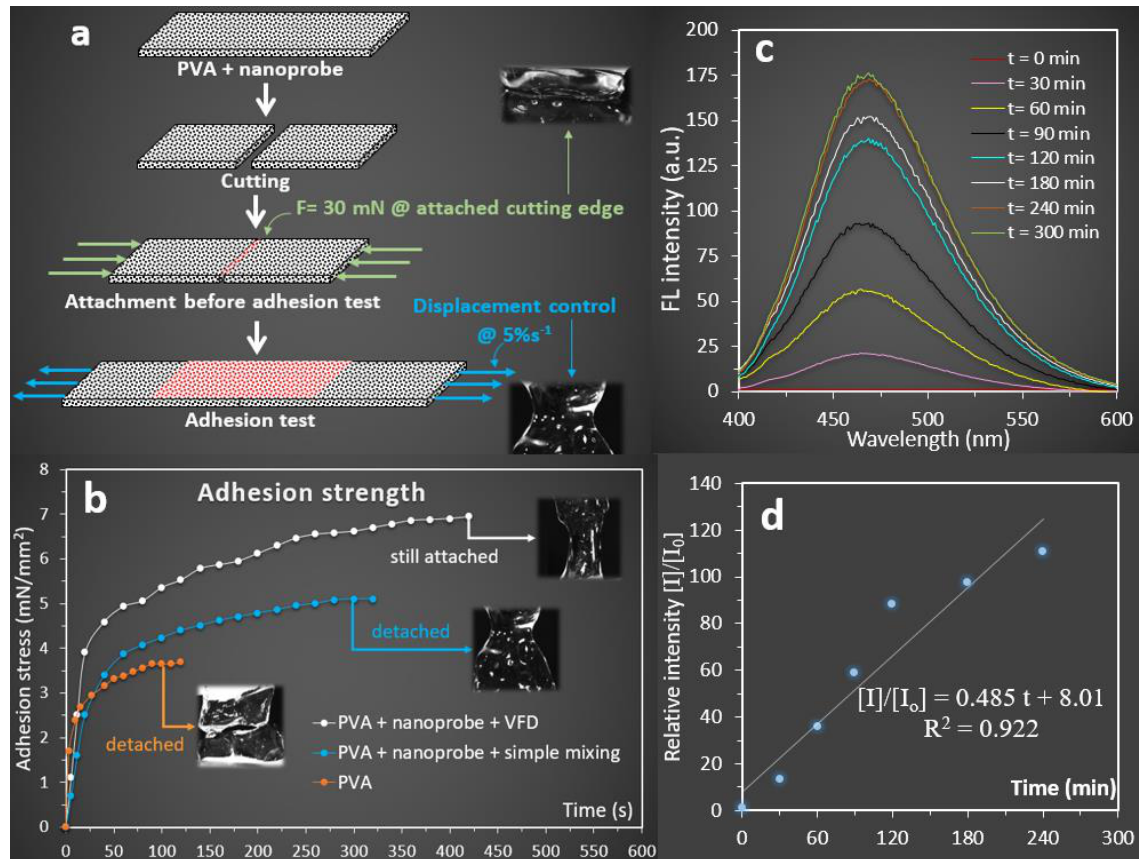
Figure 6. ( a ) Schematic drawings including camera images to describe the adhesion test procedure. ( b ) Comparison of the adhesion strength of PVA-based gels including PVA (blue line), traditionally prepared PVA + nanoprobe (blue line), and VFD-driven PVA + nanoprobe prepared at 4000 RPM (red line). Inset: camera images (×4) were captured during the measurement of the self-adhesion property. ( c ) Change in the fluorescent intensity of the release media showing the release of nanoprobe from the injectable bioadhesive PVA gel over time, and ( d ) change in relative fluorescent intensities of the release media at different time points, compared to t = 0 min, indicating almost a linear release behaviour for the gel.